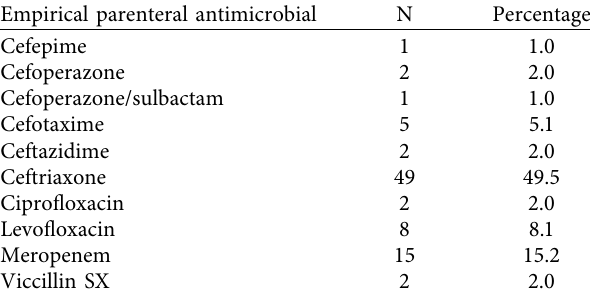
Table 3: The use of empirical antibiotics in pneumonia patients.